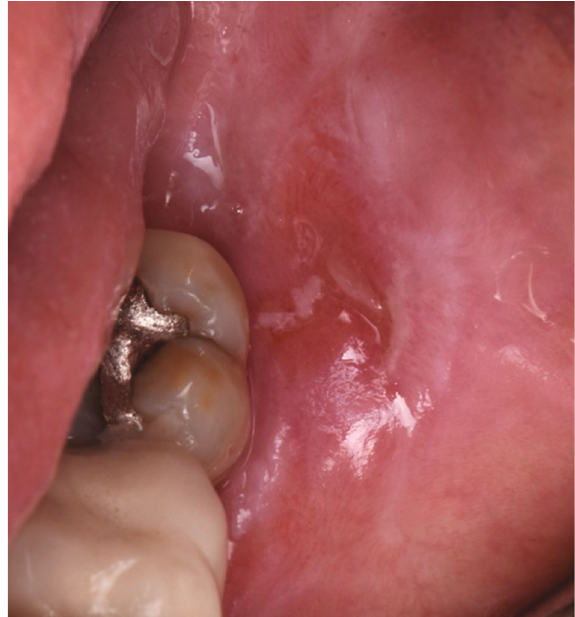
Figure 2: Lichenoid lesion related to tooth #37.